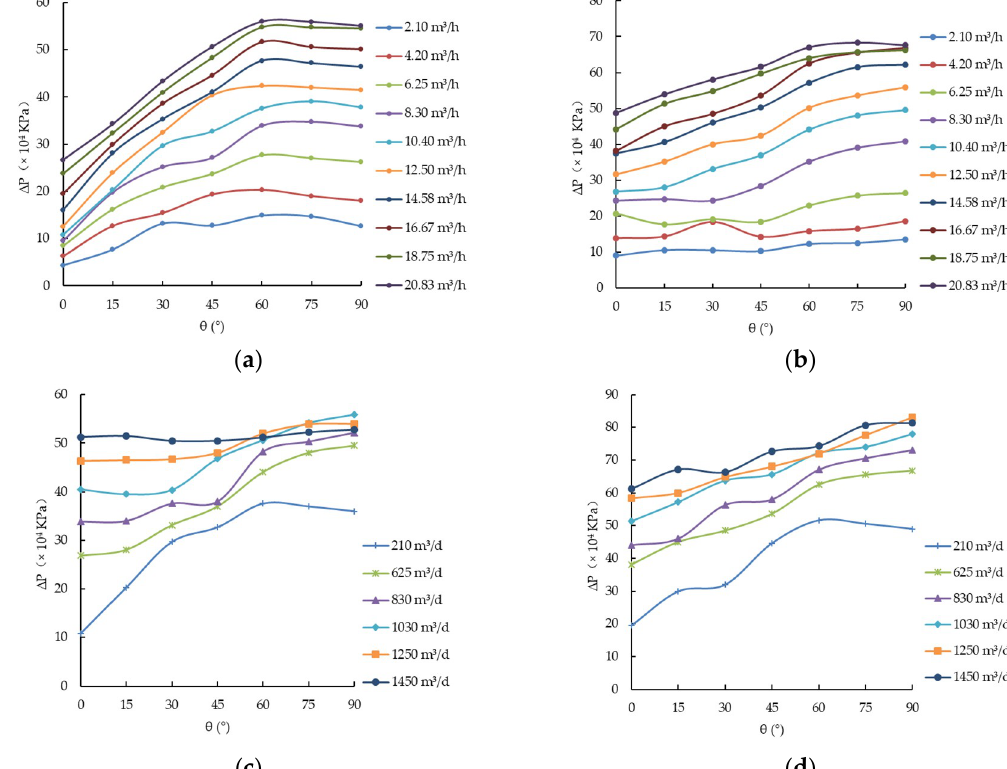
Figure 2. The law of pressure drop with angle: ( a ) when gas rate is 210 m 3 /h; ( b ) when gas rate is 625 m 3 /h; ( c ) when liquid rate is 10.40 m 3 /h; ( d ) when liquid rate is 16.67 m 3 /h.